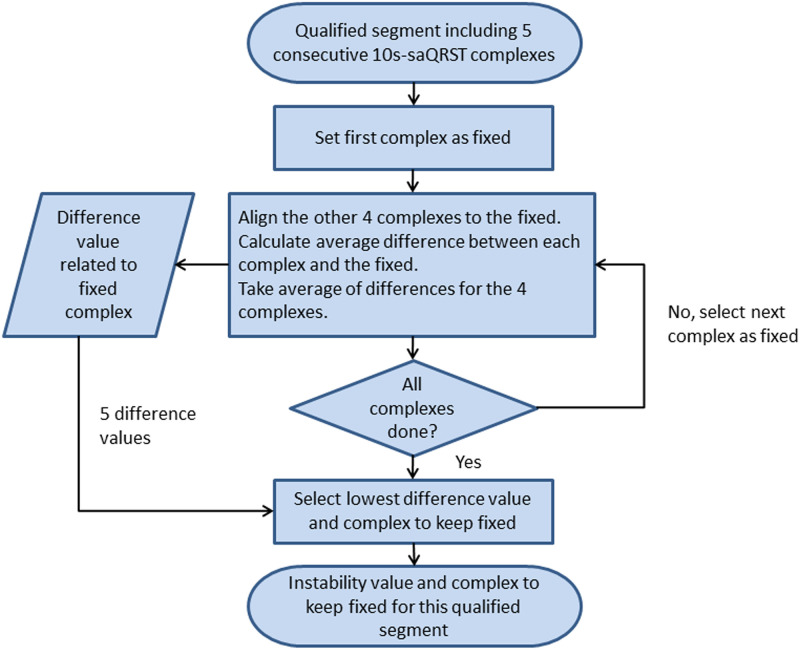
Flow-chart showing the series of instability calculations.The flow-chart describes the process for arriving at an instability value for a 50s qualified segment consisting of 5 consecutive 10s-signal-averaged-complexes (saQRST complexes) of the recording applying the methods described in Fig 1. This process was repeated for all qualified 50s segments of an individual recording and the segment with least variability was referred to as the selected segment from which the most representative 10s-saQRST complex was chosen for the calculation of 28 vectorcardiographic parameters.